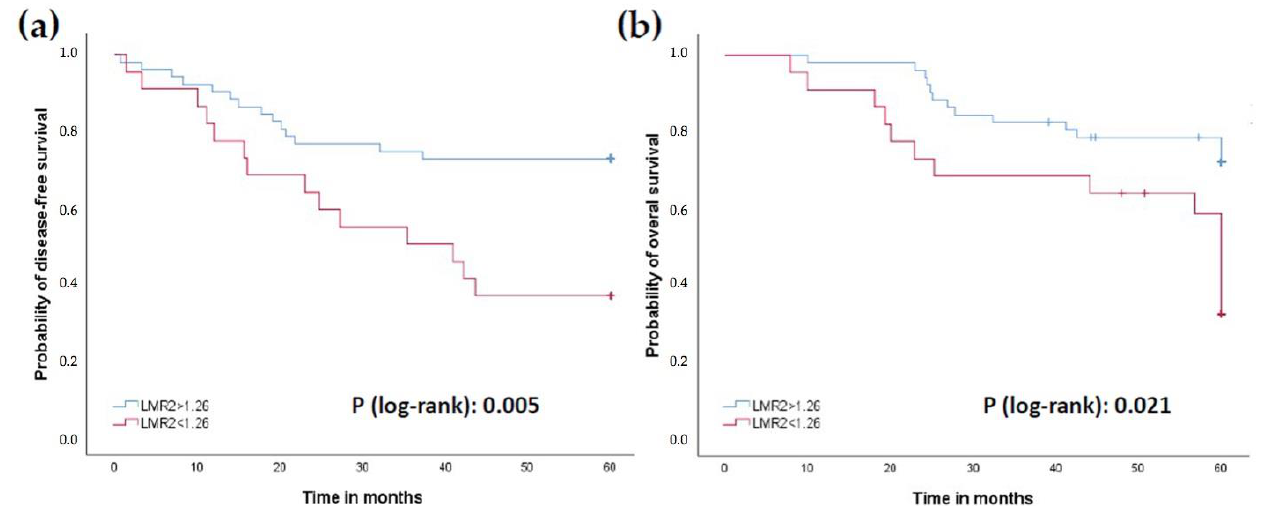
Figure 3. Prognostic role of Hb2 levels with a cut-off value of 12.3 g/dL. ( a ) Progression-free survival (PFS). ( b ) Overall survival (OS).